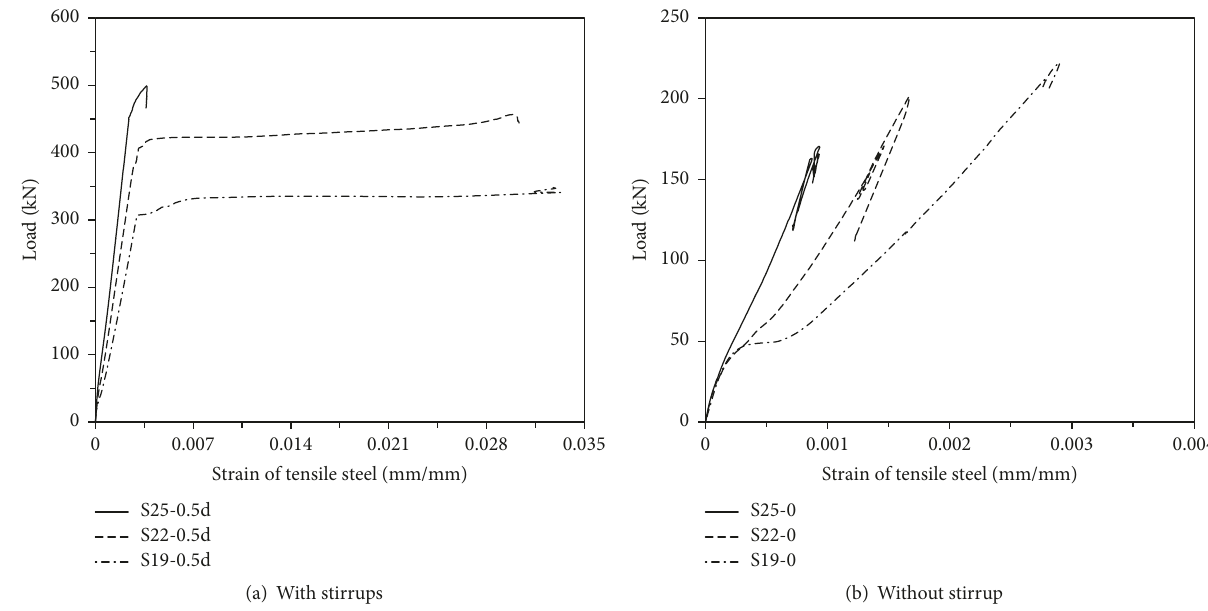
Figure 9: Load versus strain of tensile steel in shear test